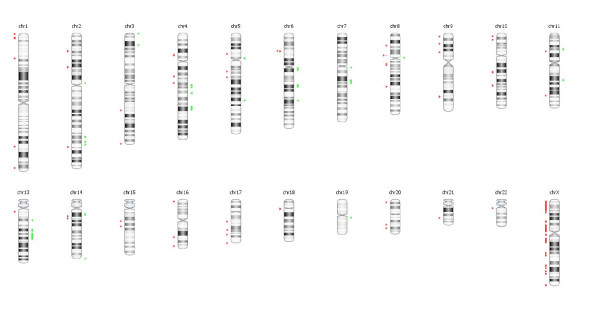
Overview of copy number alterations for all chromosomes. Red: loss, green: gain.